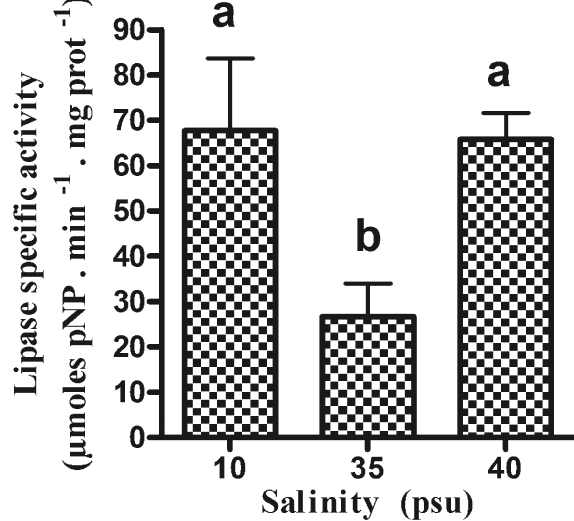
f ig 2. – Effect of acclimation to low and high salinity on lipase ac- tivity in hepatopancreas of C. angulatus. The activity was measured as described in the Materials and Methods section in the presence of 0.7 mM p-nitrophenylpalmitate (pNPP) at pH 8.5 and at 37°C. Different letters indicate significant differences ( P <0.05). Data are mean ± SE for 5